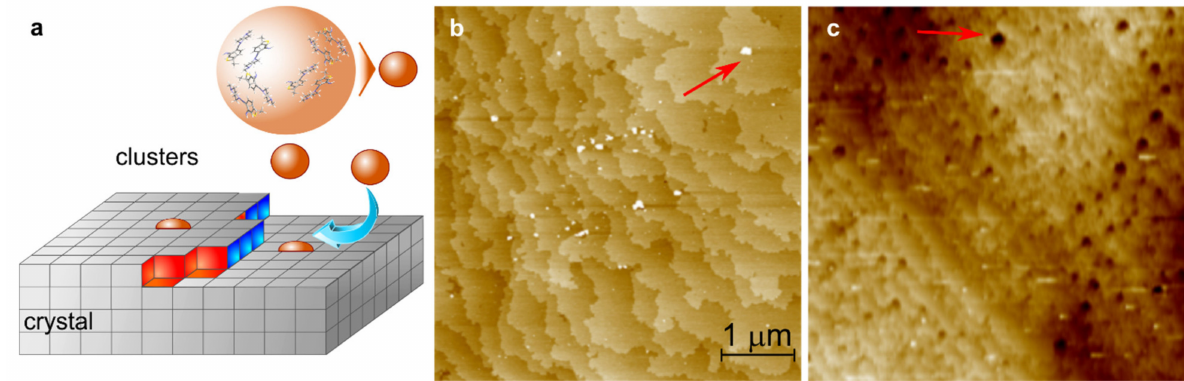
Figure 4. Contribution of mesoscopic solute-rich clusters to OZPN crystal growth. ( a ) Schematic of. Schematic of the potential contribution. ( b ) Clusters (indicated with a red arrow) formed in OZPN EtOH/H 2 O solution land on OZPN crystal surface at C ==2.68 mM. ( c ) Scanning with increased tip force reveals that clusters partially incorporated into the crystal (indicated with a red arrow) etch faster than the underlying crystal, revealing that they do not integrate into the crystal